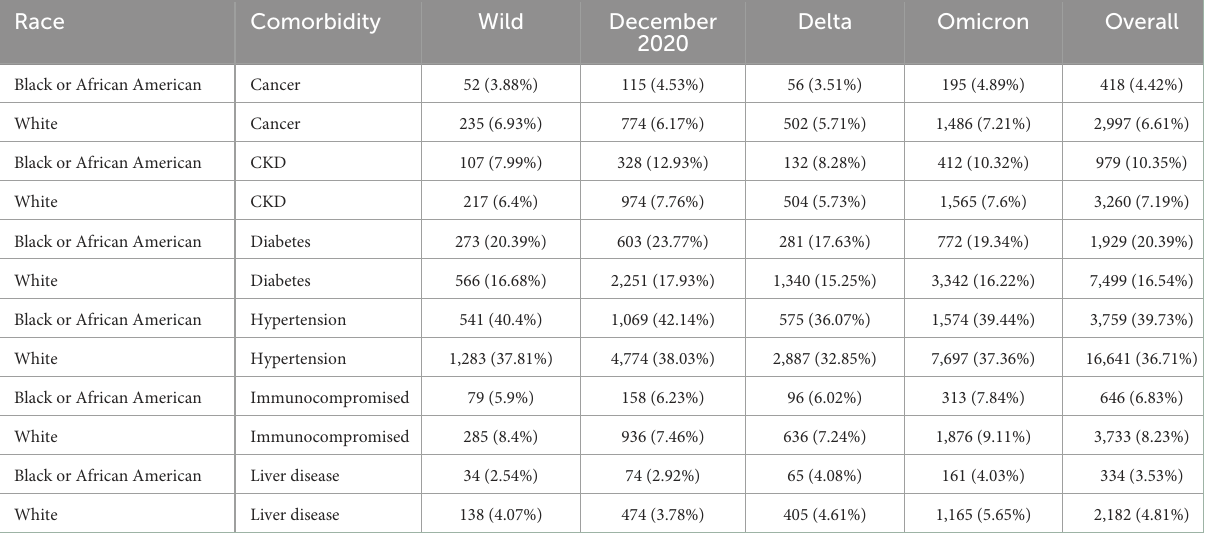
TABLE 2 Percentages of each population (Black patients and White patients) for each comorbidity (the age distributions are given in Figure 2) by COVID wave. Race Comorbidity Wild Delta